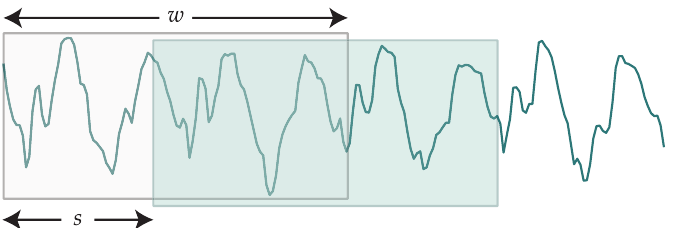
Figure 7. Conceptualization of a sliding window of size w and step s applied over one